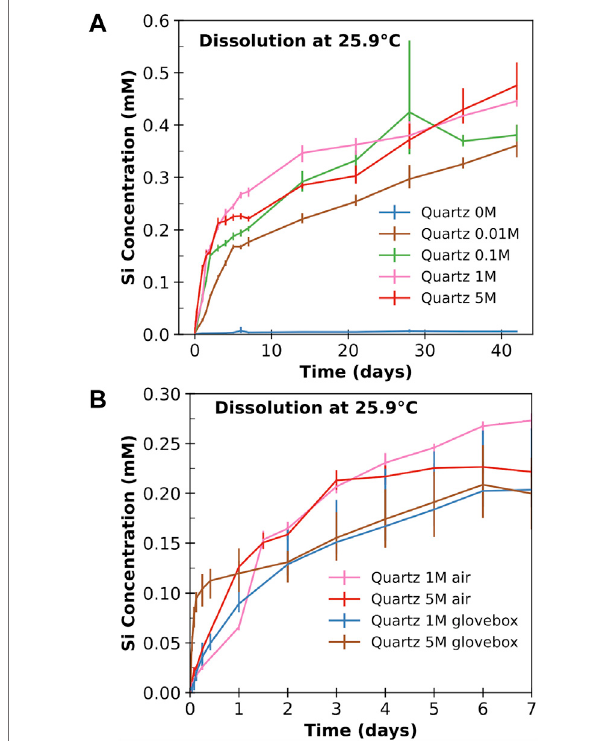
FIGURE 2 | The evolution of dissolved Si concentration in mM (i.e., mmol/L) from quartz powders in fi ve solutions with different NaOH molarities (0 M, 0.01 M, 0.1 M, 1 M, and 5 M) as a function of time at a temperature of 25.9 ° C. (A) shows the results from experiments performed in air, while (B) compares the data from air and glovebox experiments for 1 and 5 M NaOH. The values in the fi gure are the averages of three ICP-OES measurements, with the error bars indicating the range of the measured